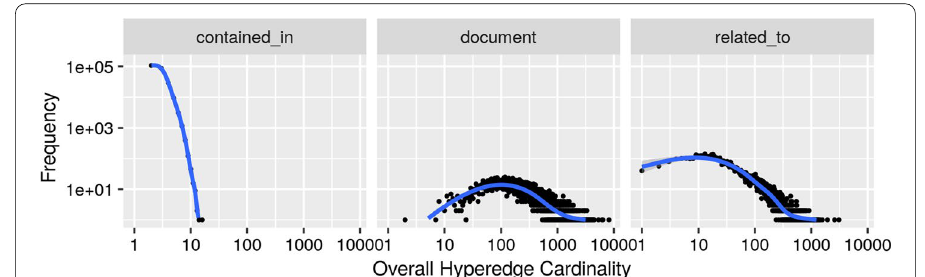
Fig. 2 Hyperedge cardinality distribution based on the total number of nodes for the base model (log–log scale)